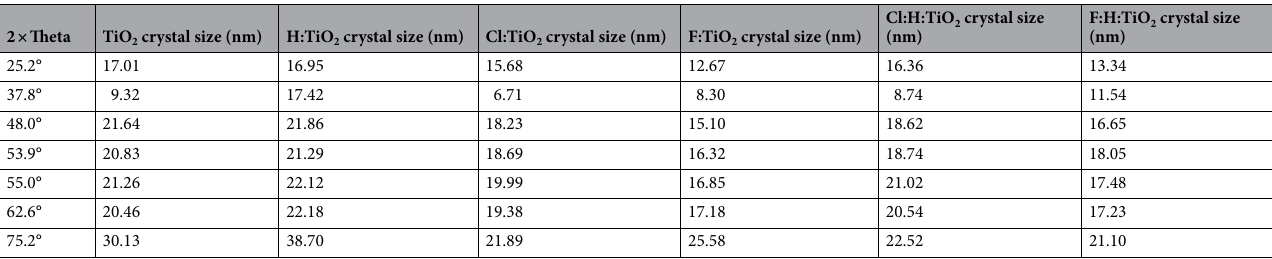
Table 1. The crystal size of each structure as calculated with the Scherrer–Debye